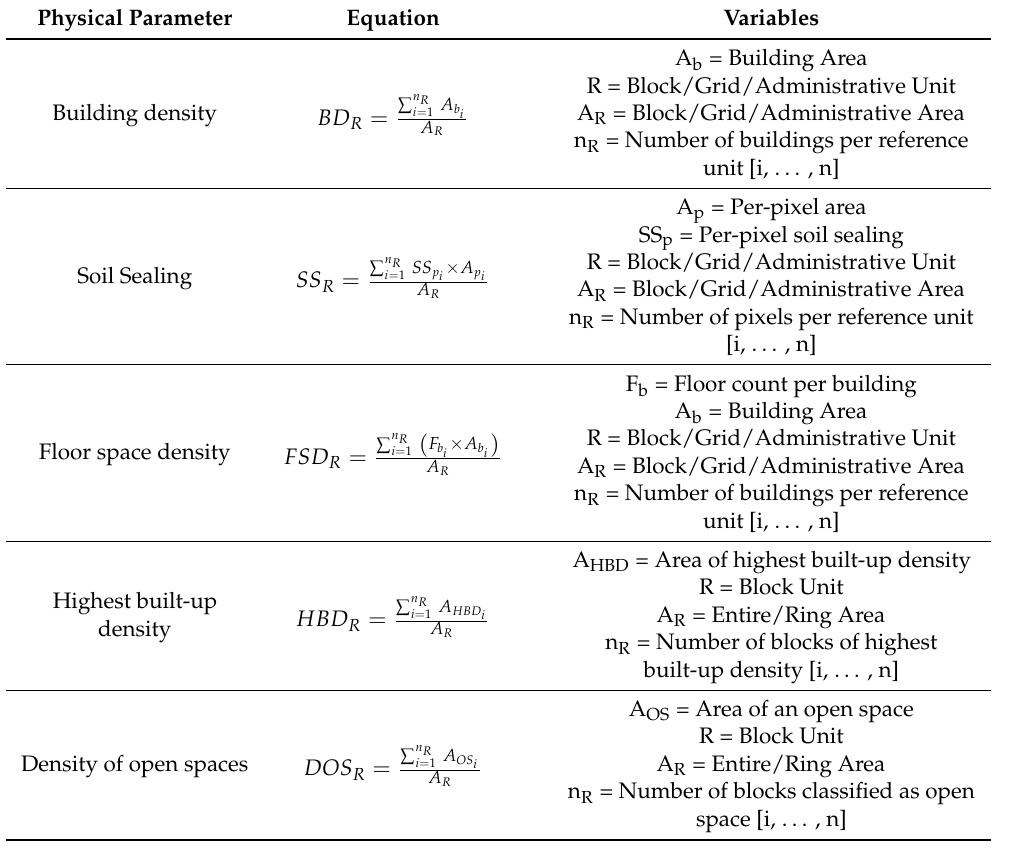
Table 1. Overview of the parameters for measuring physical